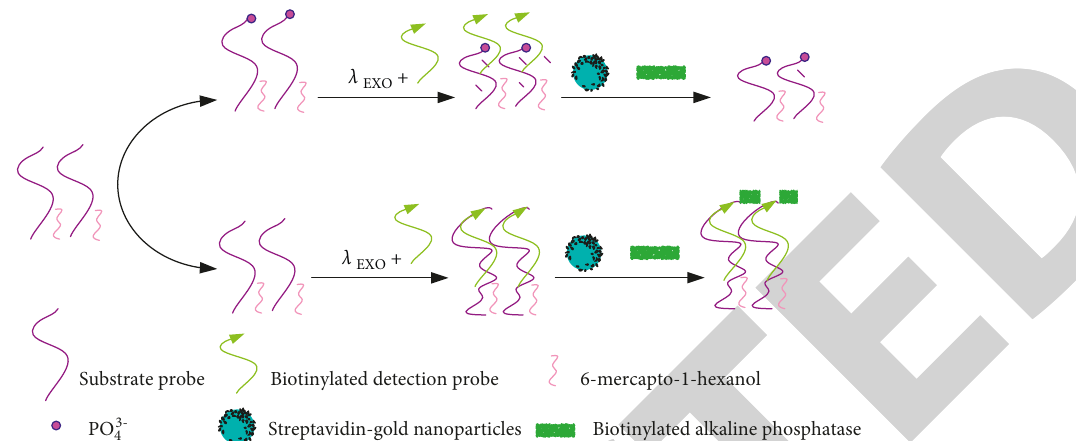
Figure 2: Schematic diagram of the basic principle of detection of PNK activity based on electrochemical signal amplification.